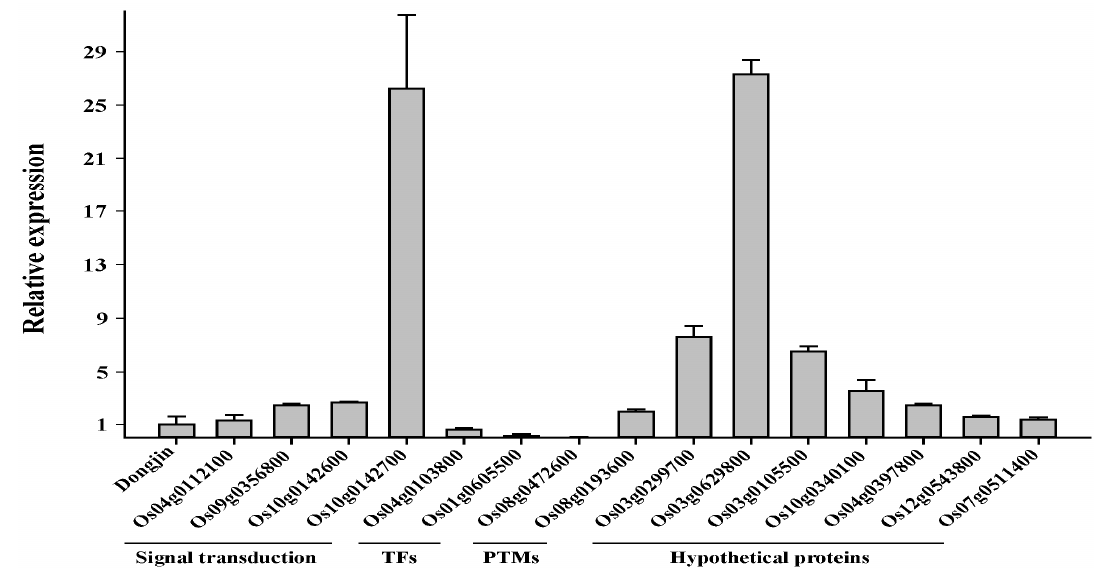
Figure 6. Quantitative RT-PCR (qRT-PCR) results for the differentially expressed transcripts in wild type (DJ) and the Osfuct mutant (HM) to verify transcriptome profile data produced by microarray analysis. Data are mean ± SD ( n = 3). Int. J. Mol. Sci. 2018 , 19 , x